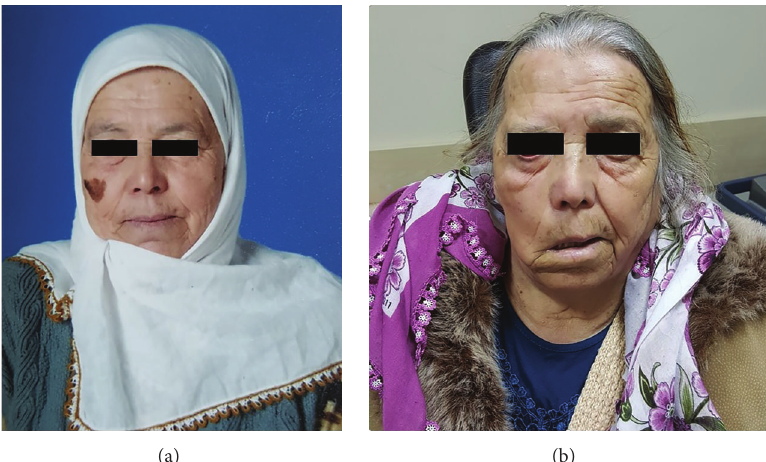
Figure 3: (a) 3 × 3cm hyperpigmented lesion in the right facial region was detected in photographs that were taken five to six years ago. (b) The spontaneous regression of hyperpigmented